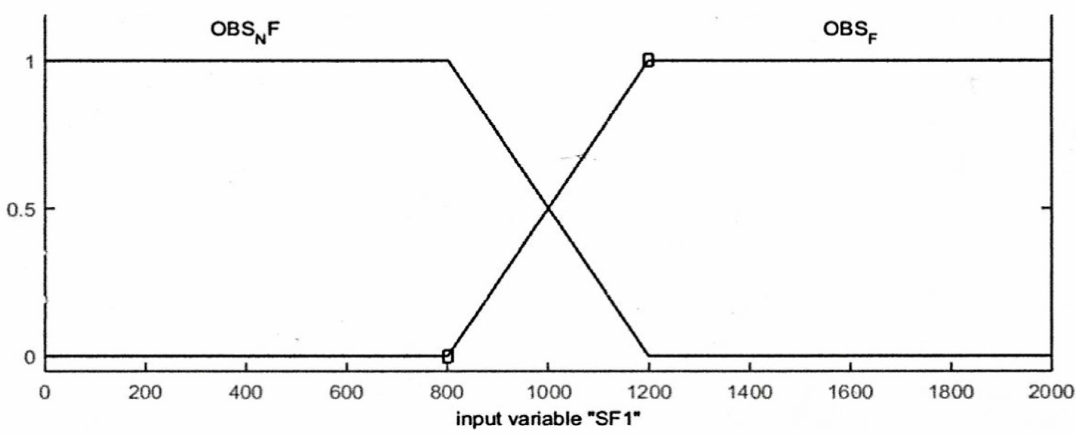
Figure 4. Input membership functions for the distance sensors.